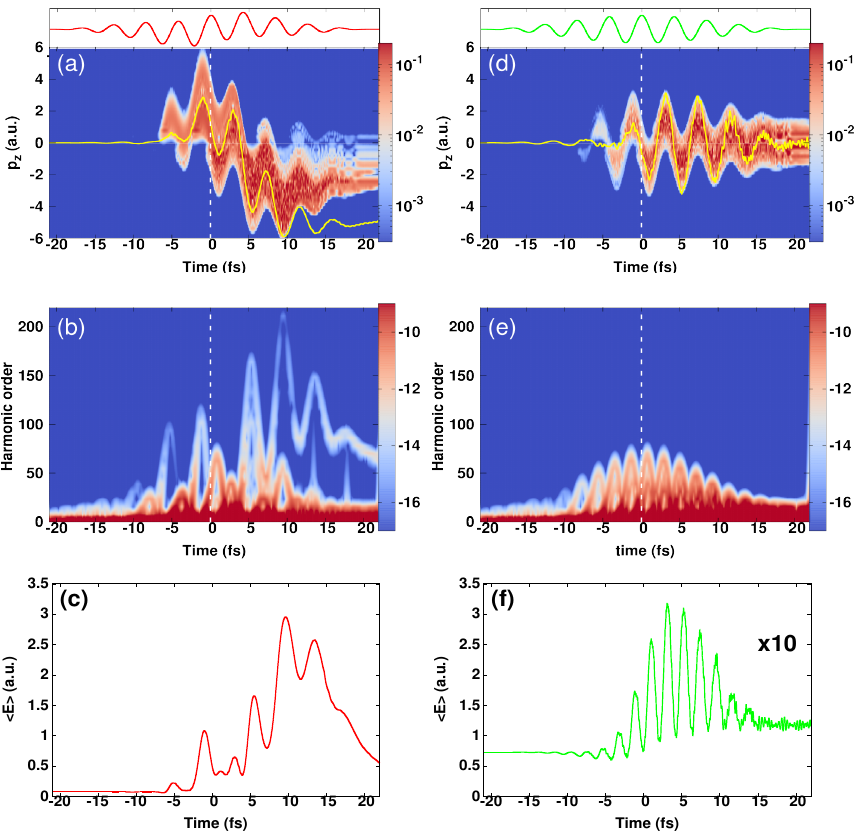
Figure 3. (Color online). 1D—calculations performed with only the NIR pulse (right column) and when assisted with the IR pulse (left column). Top: ( a , d ) Time evolution of the density of the ionized electrons. In the same figures are shown the electron currents (yellow curves). Middle: ( b , e ) time— frequency analysis of the harmonic spectra. The white dashed lines indicates the zero time. Bottom: ( c , f ) expectation value of the kinetic energy < E > . The data in Figure ( f ) are multiplied by 10 due to a weak amplitude of < E > . The parameters of the NIR pulse are: λ NIR = 1.27 µ m, T c = 10 cycles, δφ = 0 and I NIR = 1 × 10 14 W/cm 2 . The parameters of the IR pulse are: λ IR = 12.7 µ m and I IR = 1 × 10 13 W/cm 2 . Insets: laser pulses taken from Figure